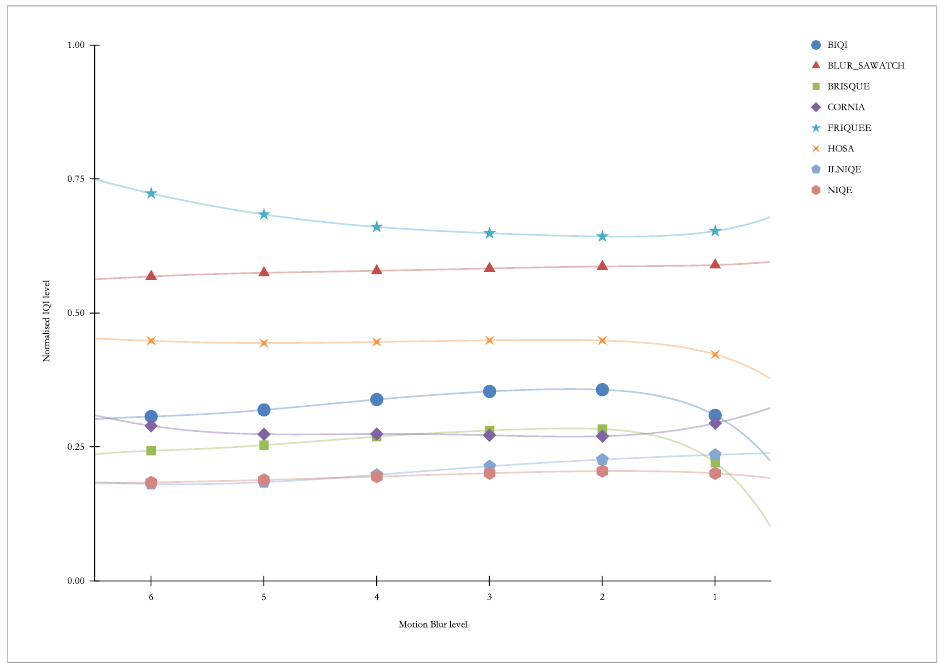
Figure 20. “Other” indicators vs. Motion Blur [ σ